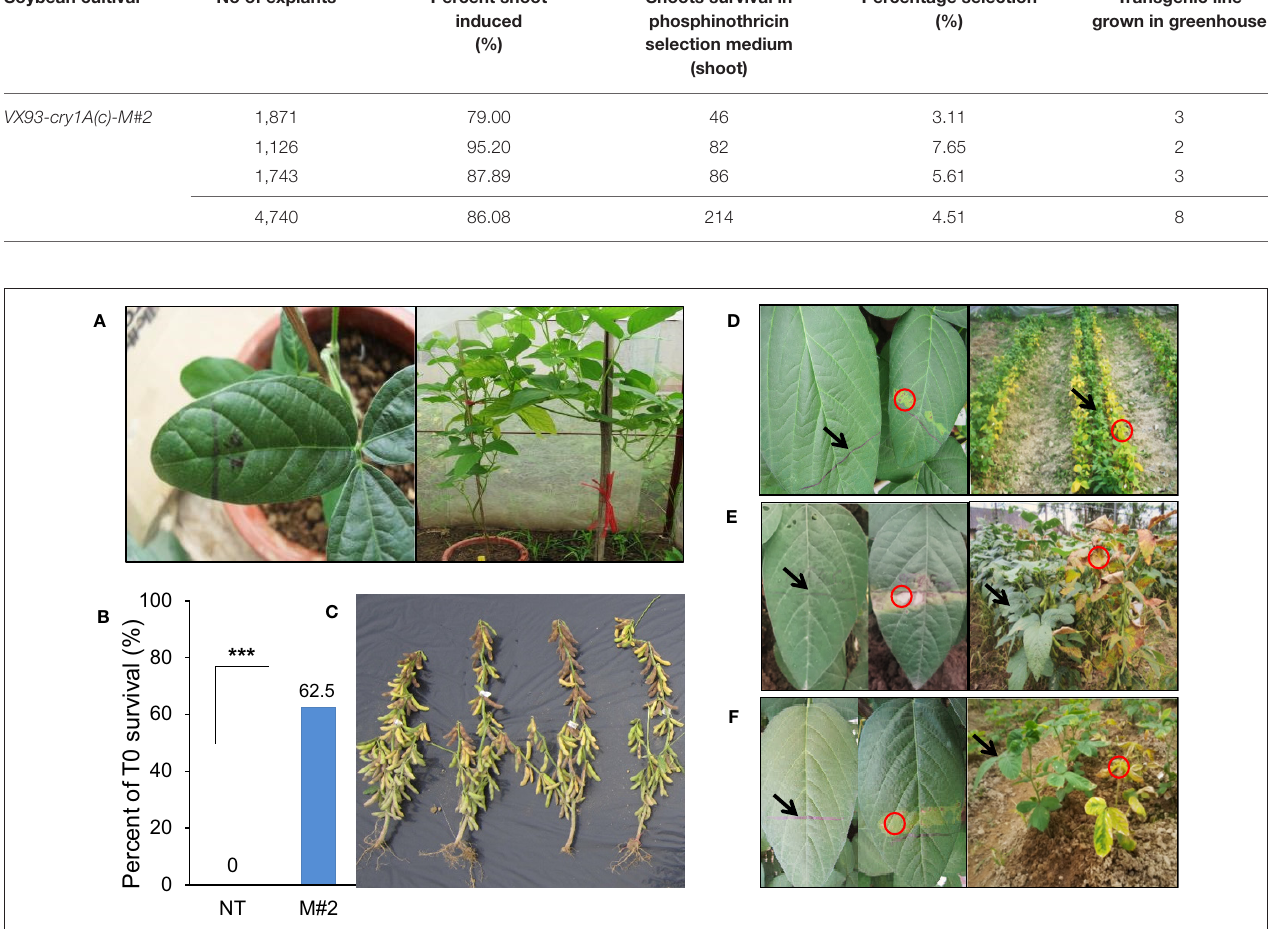
FIGURE 2 | Evaluation of herbicide tolerance from T0 to T3 generation. Three days visualized the morphology of leaf response to PPT.5% following line marker and sprayed basta 0.3% for VX93 transgenic plants in the field after 5 days. (A) T0 generation assessed PPT.5mg mL − 1 . (B) T0 survival. (C) T0 plants. (D–F) T1 to T3 generations tested herbicide tolerance by PPT 0.5 mg mL − 1 and basta 0.3% in the field, respectively. Arrows indicate the PPT/basta resistant leaves of transgenic plants and circles are the PPT/basta sensitive leaves of control plants. ***P < 0.001.